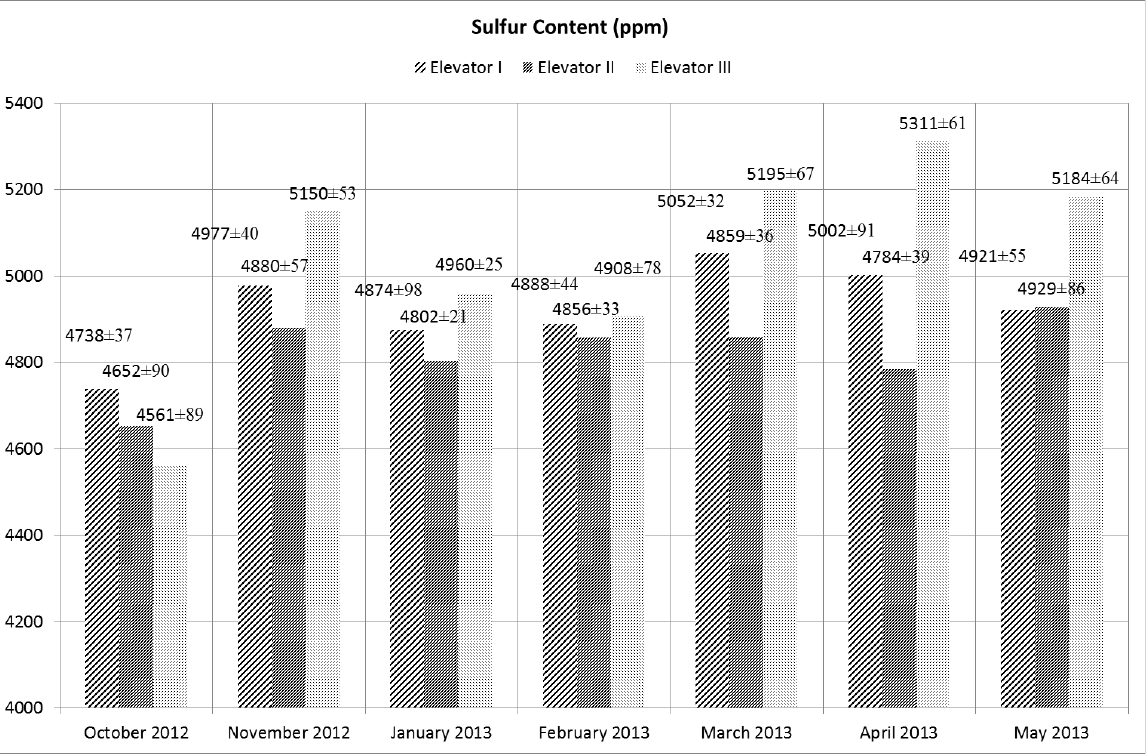
Figure 4. Sulfur concentration of Hydraulic